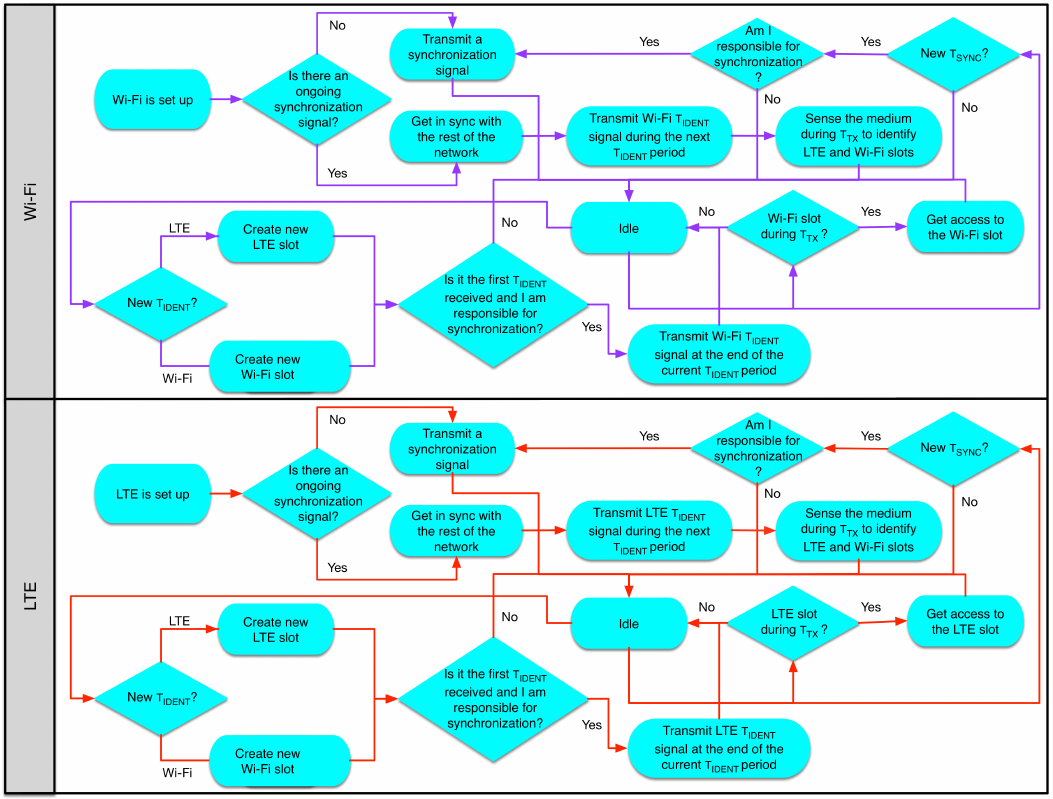
Figure 9. Enhanced CSAT flowchart.